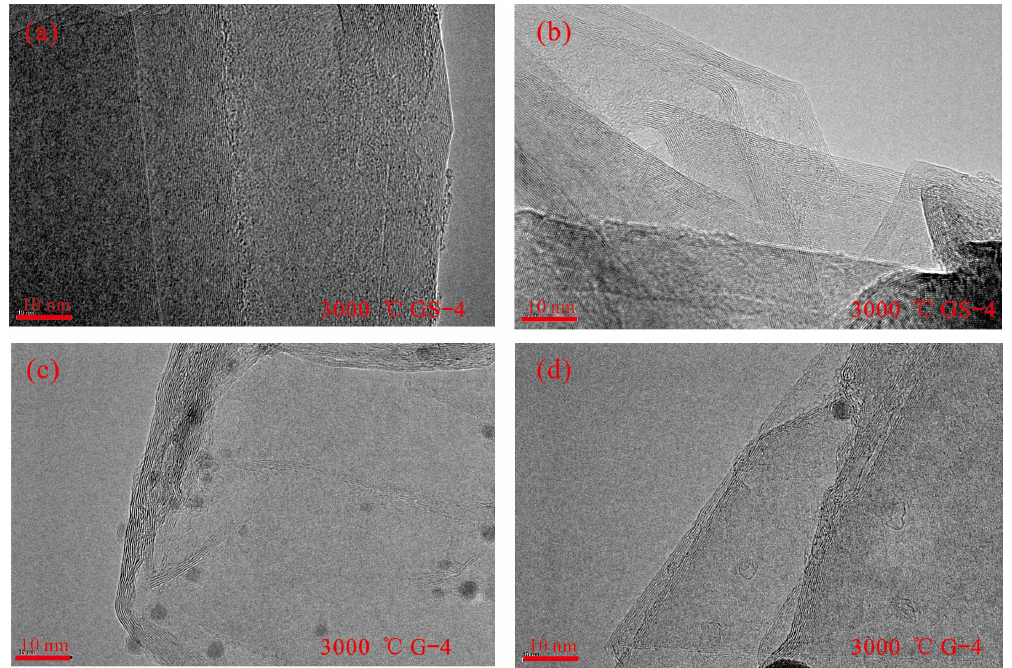
Figure 5. HRTEM characteristics of G/GS at 3000 °C. ( a ) 3000 °C GS-4; ( b ) 3000 °C GS-4; ( c ) 3000 °C G-4; ( d ) 3000 °C G-4.